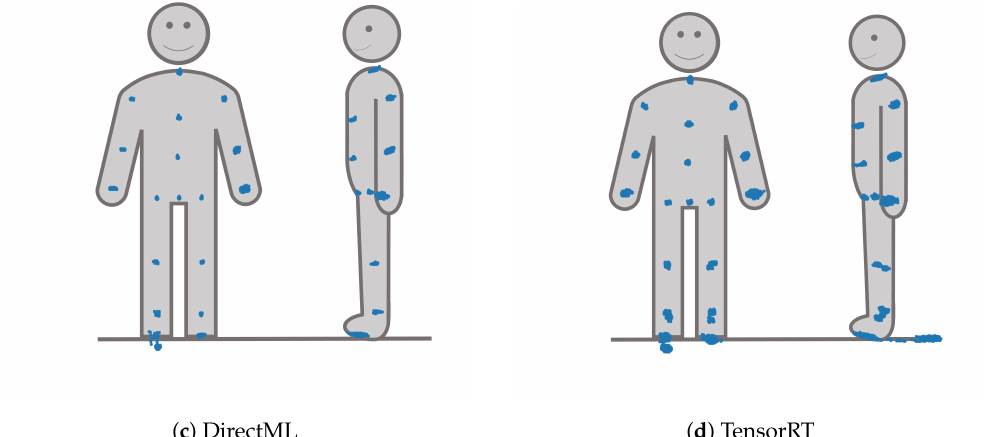
Figure 10. X -, y -, and z - y -plots of the joint positions seen from the frontal and left side perspective for all four processing modes.